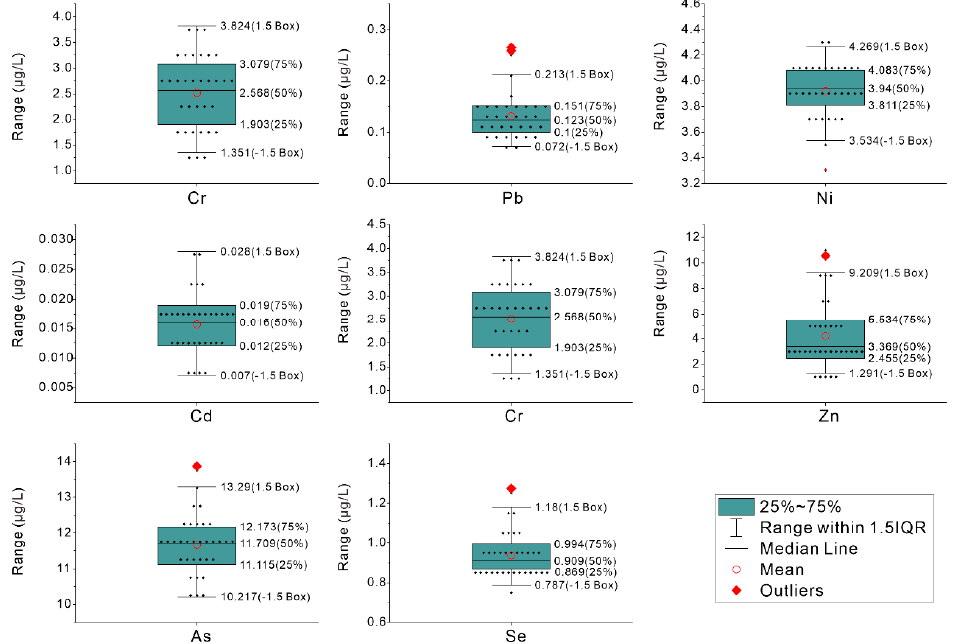
Figure 5. Vertical box plots showing the range of potentially toxic elements (PTEs) in the waters of Bosten Lake (n =